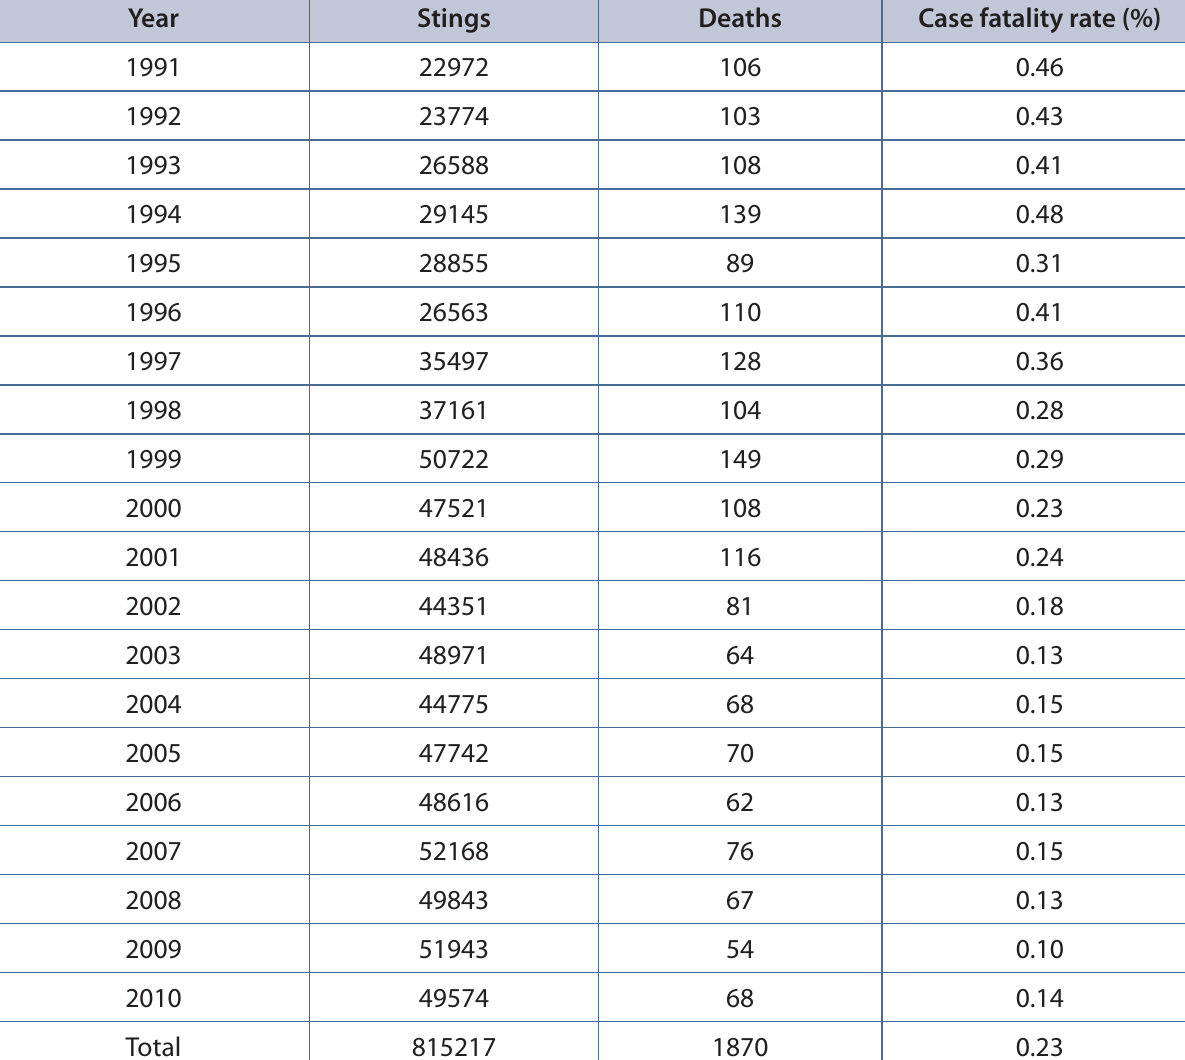
Table 1. Scorpion stings and deaths between 1991 and